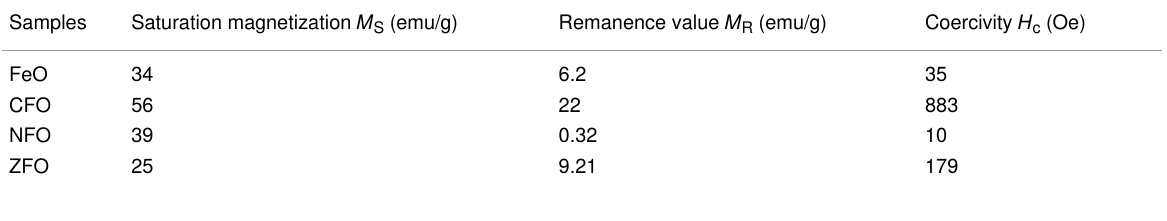
Table 3: Analysis of magnetic parameters for MFe 2 O 4 (M = Fe, Co, Ni, Zn) nanoparticles. Samples